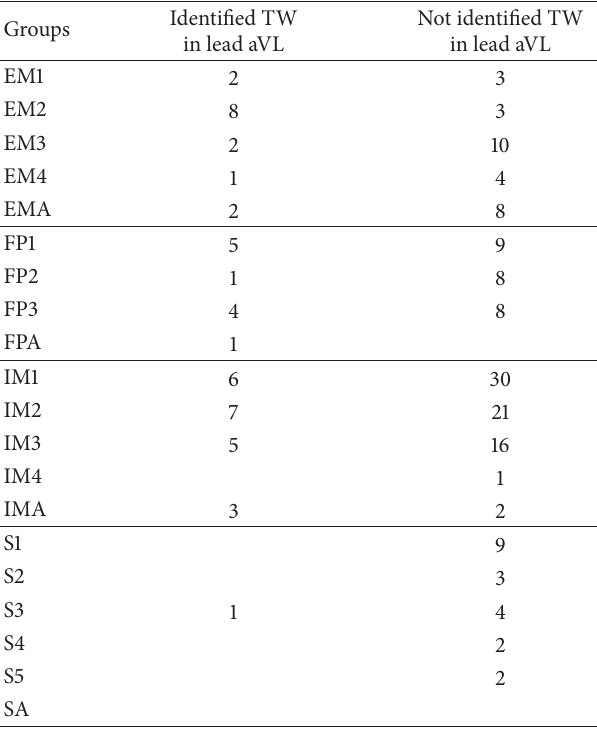
Table 1: The number of physicians who did and did not identify the isolated TWI in lead aVL by specialty and training